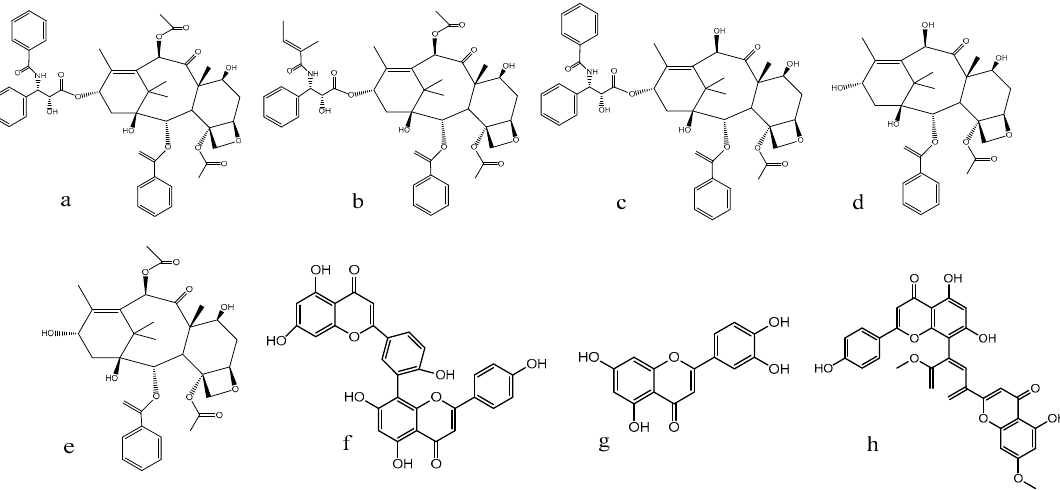
Figure 5. Structure of the five taxoids and three flavonoids. ( a ) paclitaxel; ( b ) cephalomannine; ( c ) 10-DAB; ( d ) 10-DAT; ( e ) baccatin III; ( f ) amentoflavone; ( g ) quercetin; and ( h ) ginkgetin.